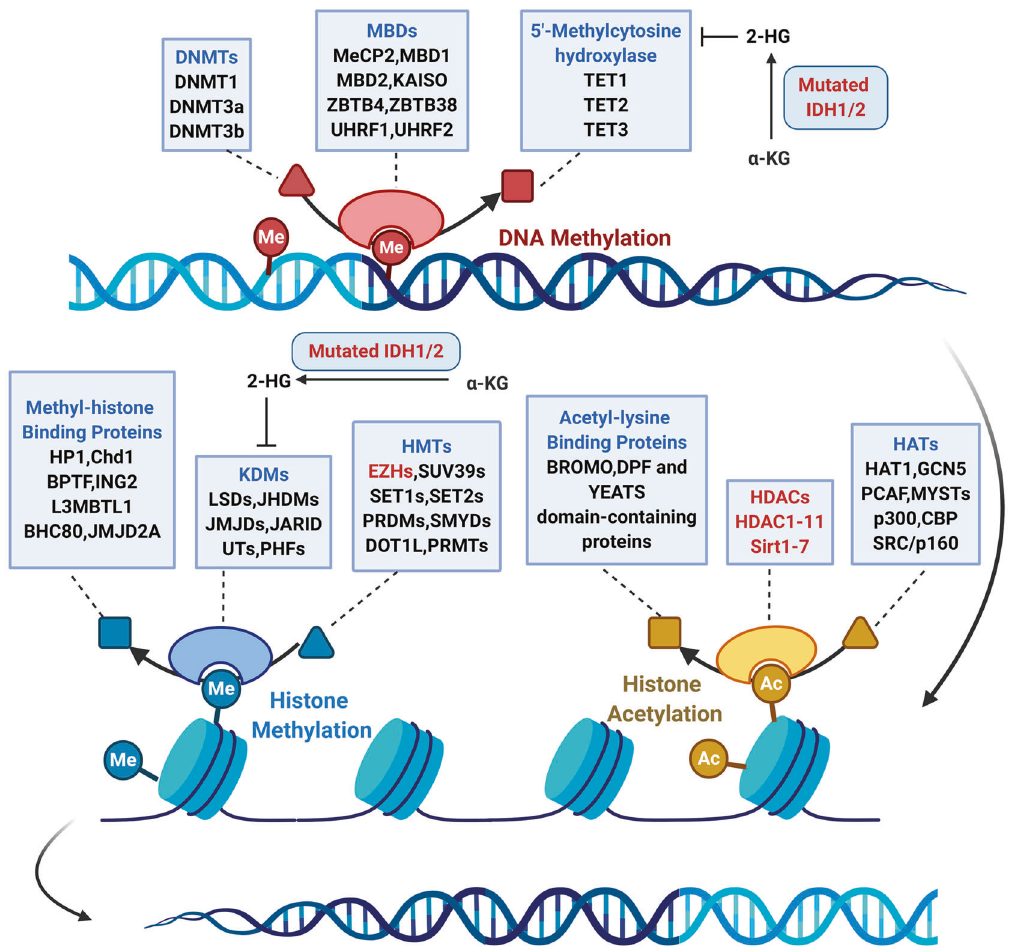
enzymes that transfer chemical groups to DNA or histones; the erasers (HDACs and KDMs) are enzymes responsible for removing chemical groups from histones; the proteins (MBDs and BET family proteins) that can recognize the methyl-CpGs and modi fi ed histones are